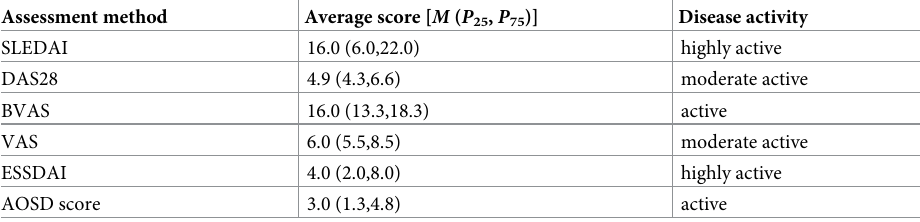
Table 2. Evaluation of disease activity for rheumatic diseases in the VTE group (n =